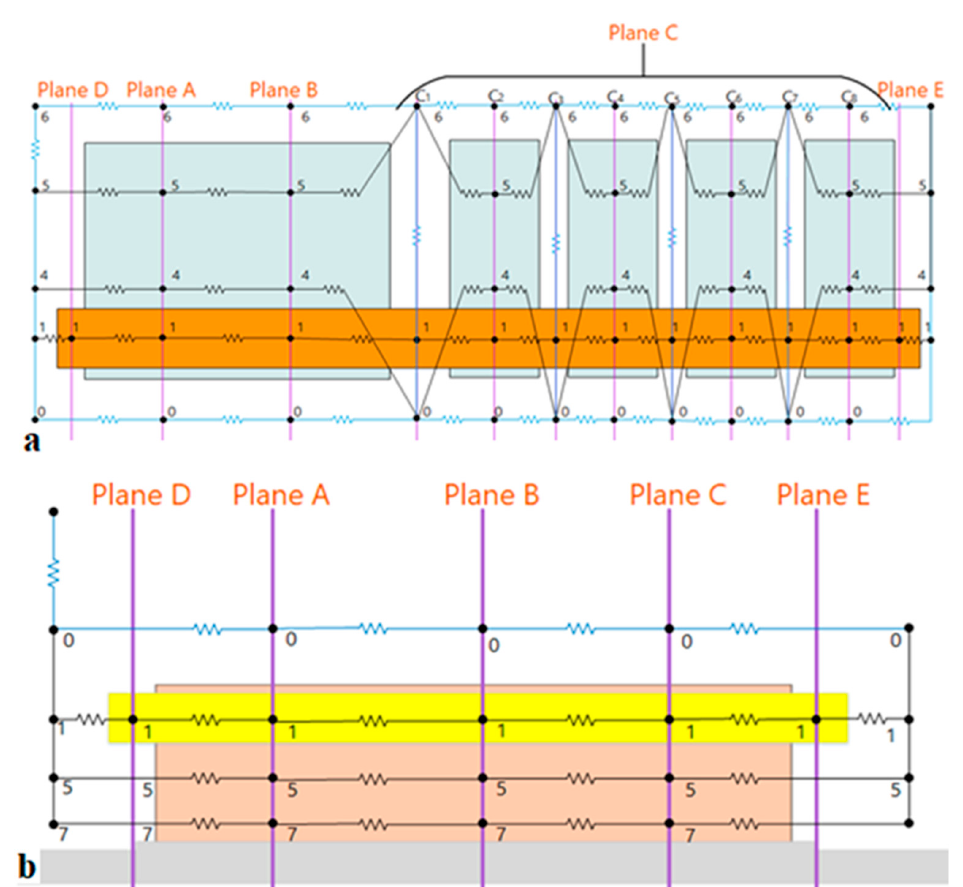
Figure 3. The proposed axial model: ( a ) stator; ( b ) rotor.